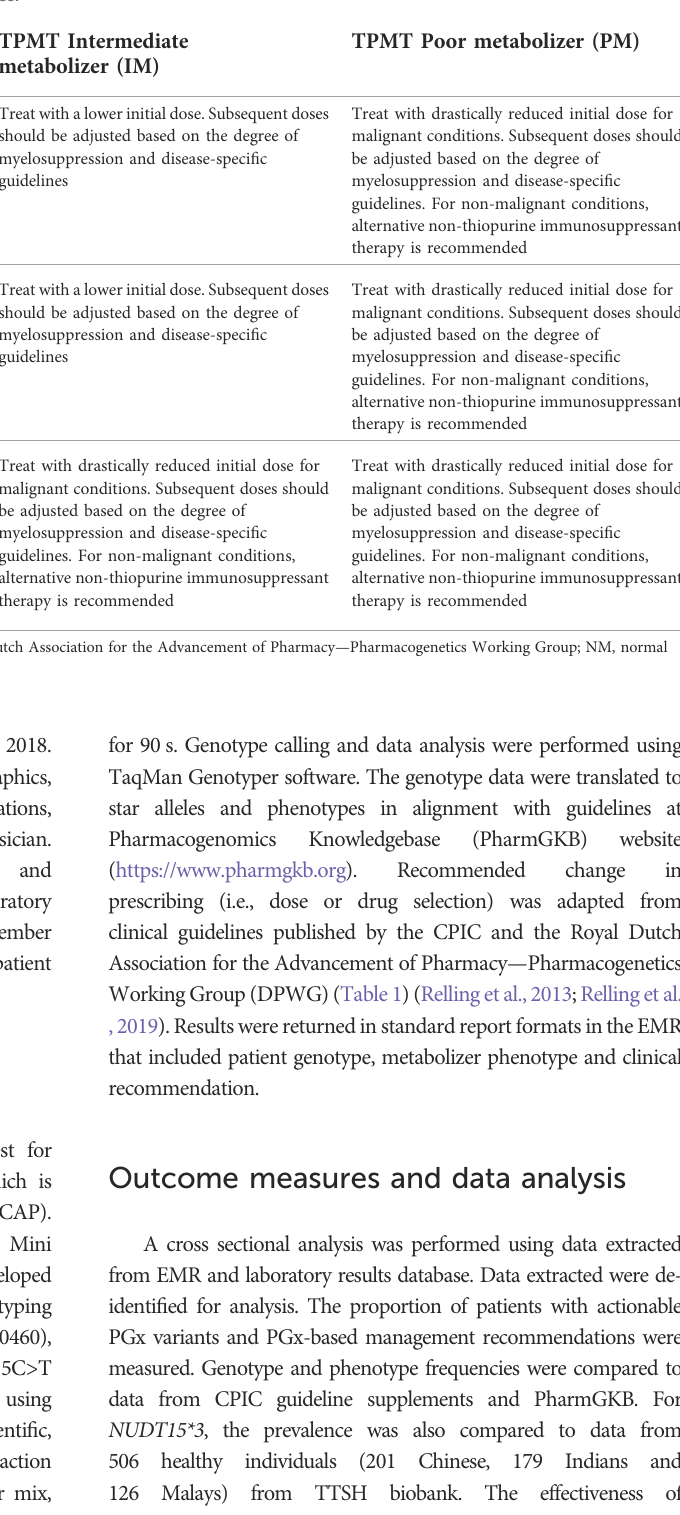
TABLE 1 Recommendations based on CPIC and DPWG